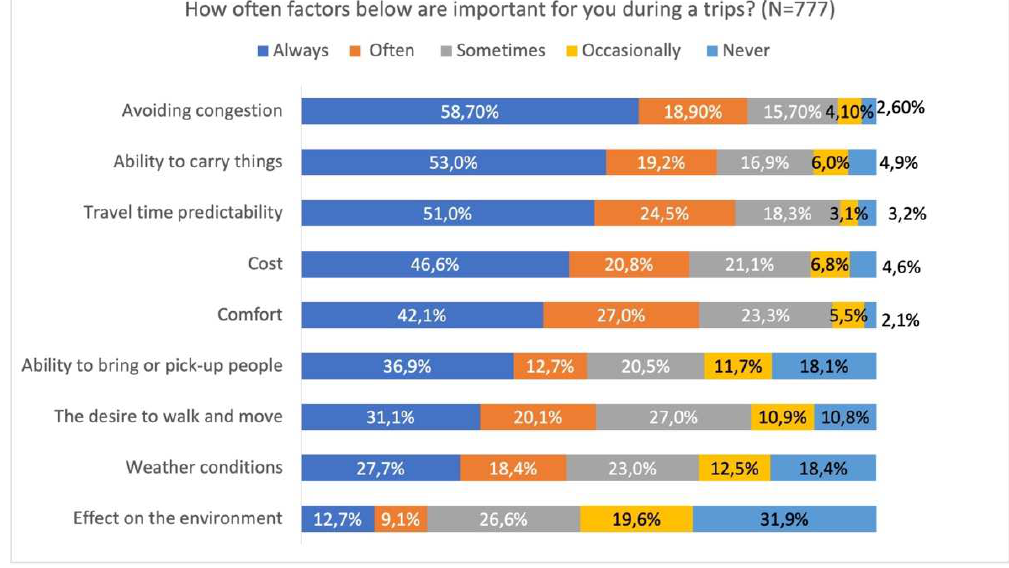
Figure 11. Preferences of respondents (N =